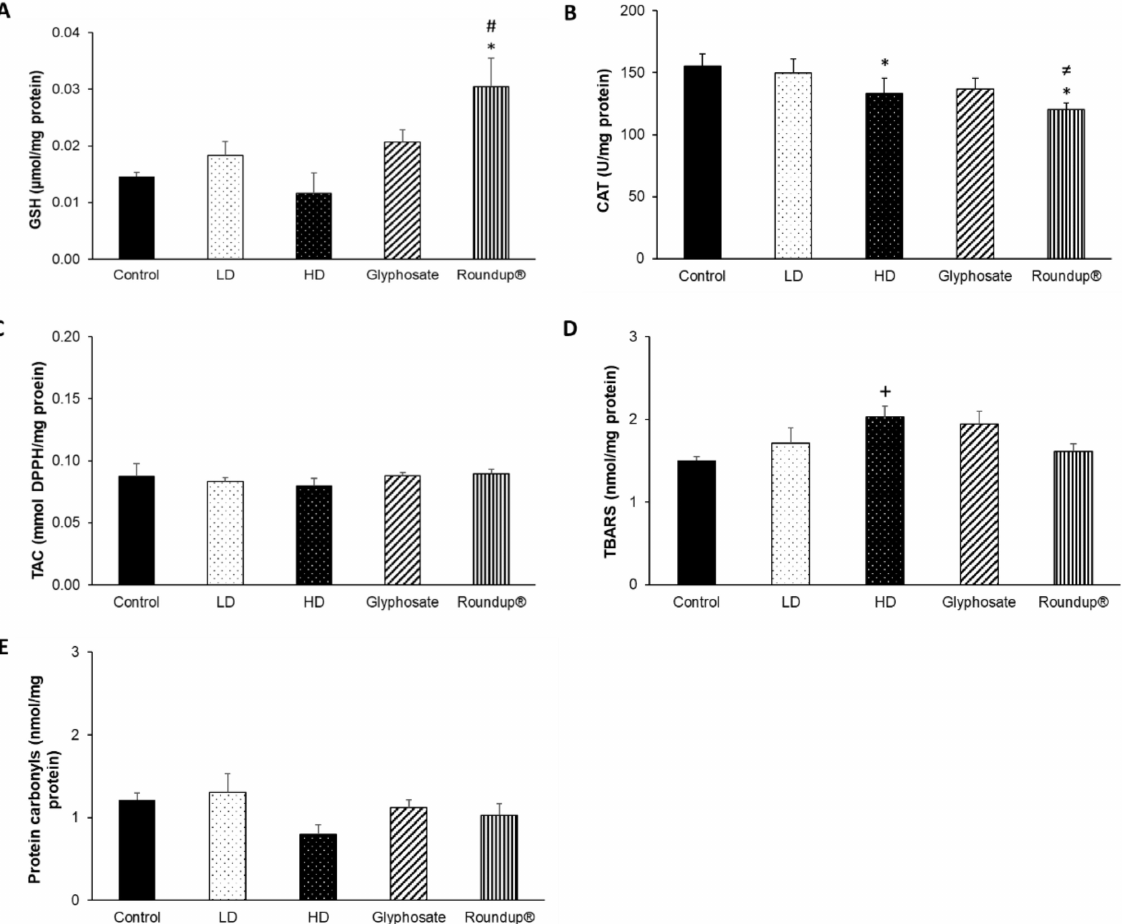
Figure 6. The effects of 12-month exposure of New Zealand rabbits to the EDs mixture, glyphosate, and Roundup ® on liver GSH concentration ( A ), CAT activity ( B ), TAC levels ( C ), TBARS levels ( D ), and protein carbonyls concentration ( E ). *: Statistically significant difference compared to the control group. #: Statistically significant difference compared to the HD group. (cid:54) = : Statistically significant difference compared to the LD group. +: Trend compared to the control group ( p =